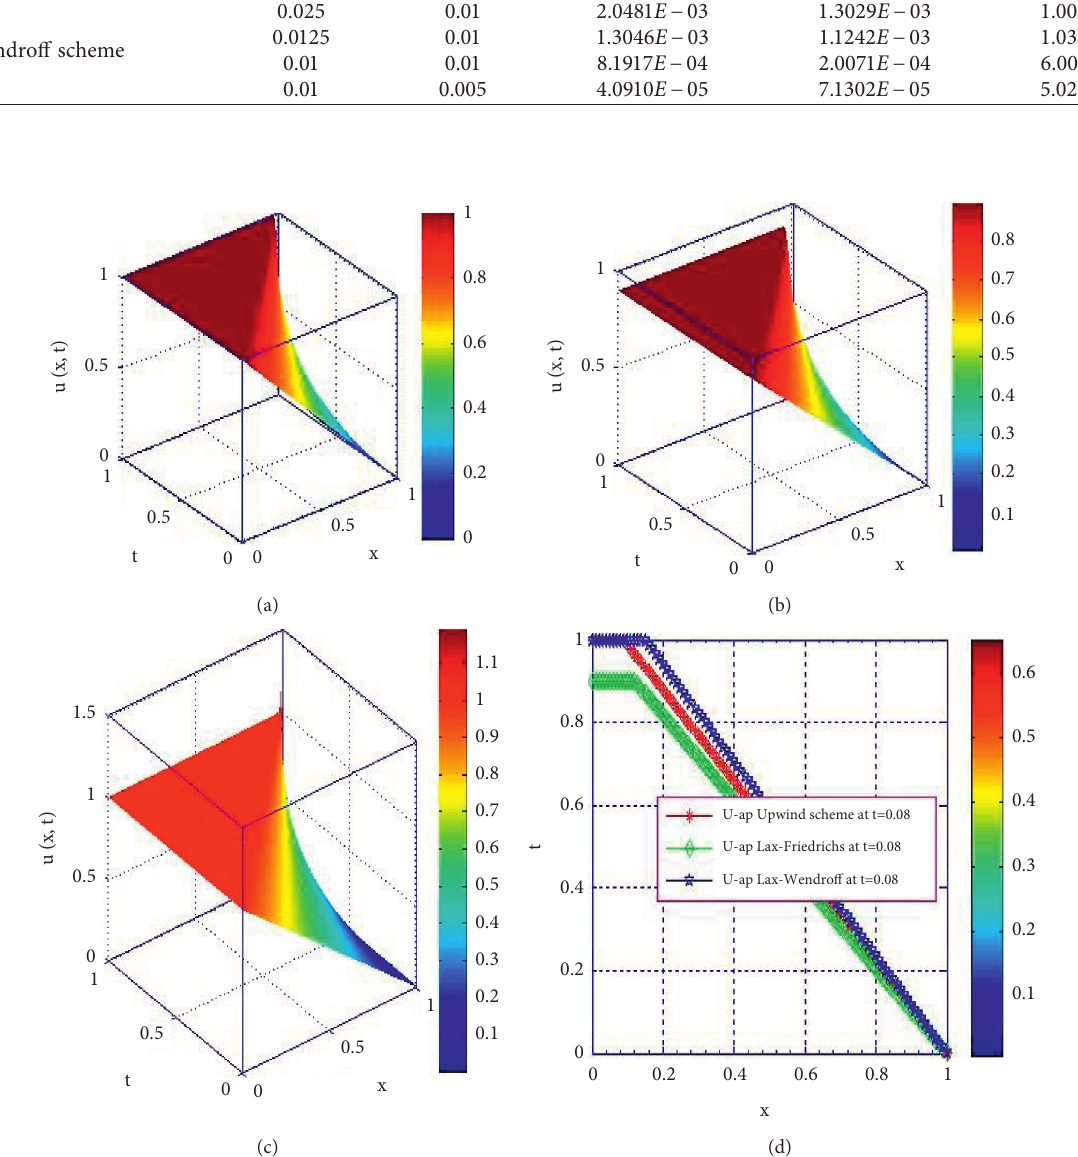
Figure 2: Solution profile of Example two subjected to piecewise continuous initial condition on the uniform mesh of maximum number grid point is Mx � 100 & time step is Δ t � 0 . 01. (a) Solution obtained by Upmind scheme; (b) solution obtained by Lax-Friedrichs scheme; (c) solution obtained by Lax Wendroff scheme; (d) comparison of numerical solution at the selected